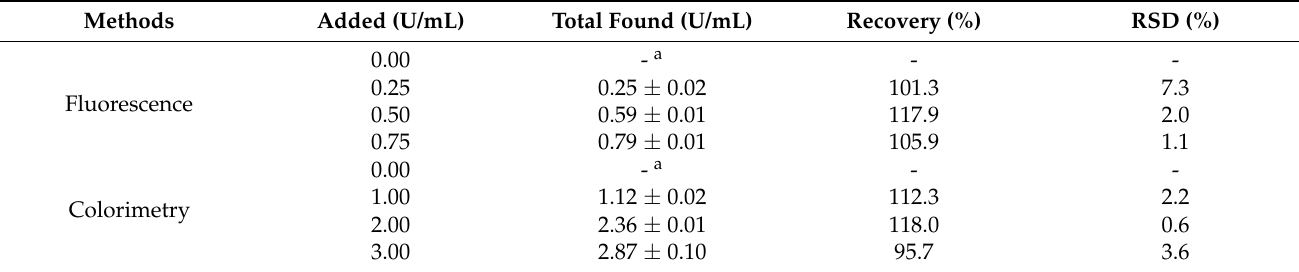
Table 2. Detection of β -glucosidase in normal human serum ( n = 3 ).